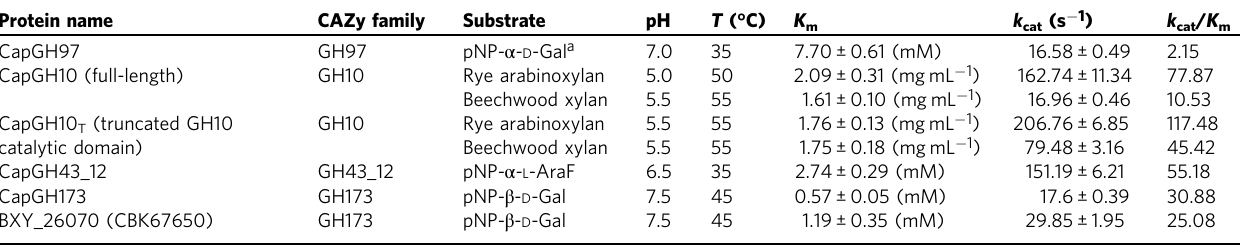
Table 1 Kinetic parameters of recombinant CAZymes. Protein